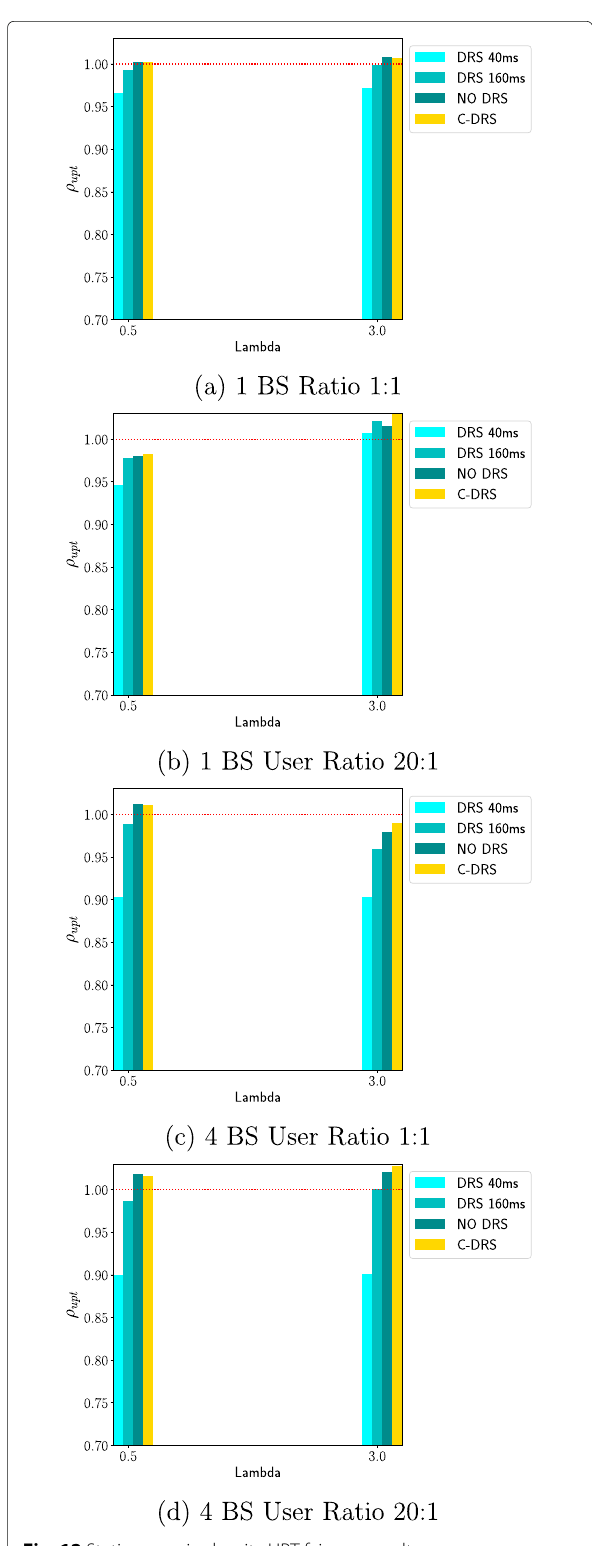
Fig. 12 Static scenario density UPT fairness